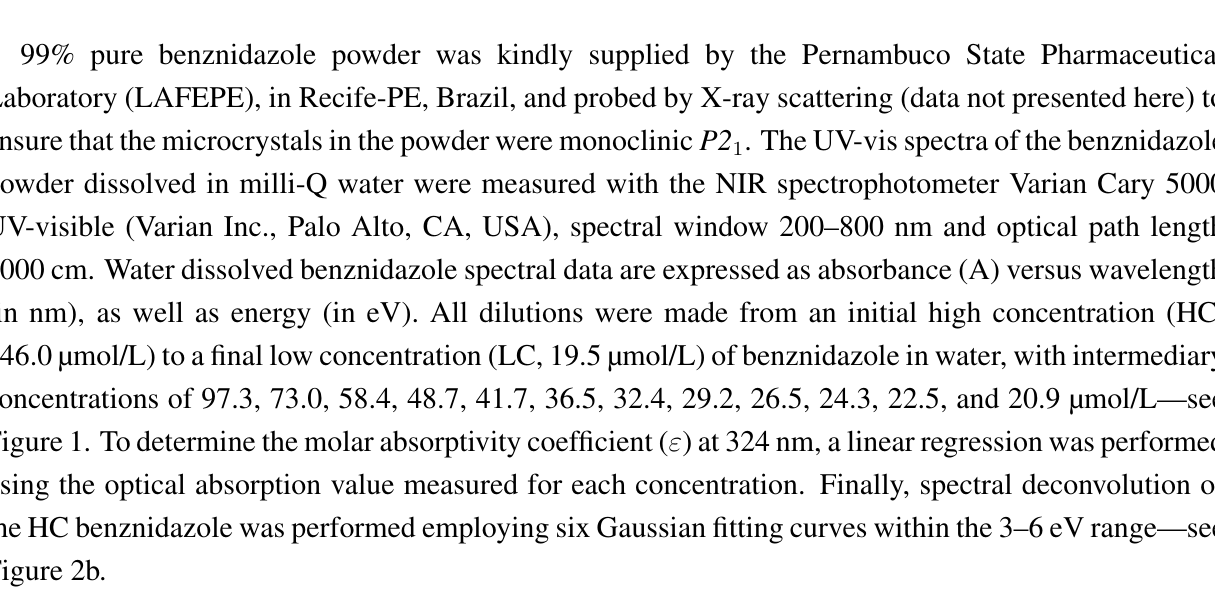
Figure 1. To determine the molar absorptivity coefficient ( " ) at 324 nm, a linear regression was performed using the optical absorption value measured for each concentration. Finally, spectral deconvolution of the HC benznidazole was performed employing six Gaussian fitting curves within the 3–6 eV range—see Figure